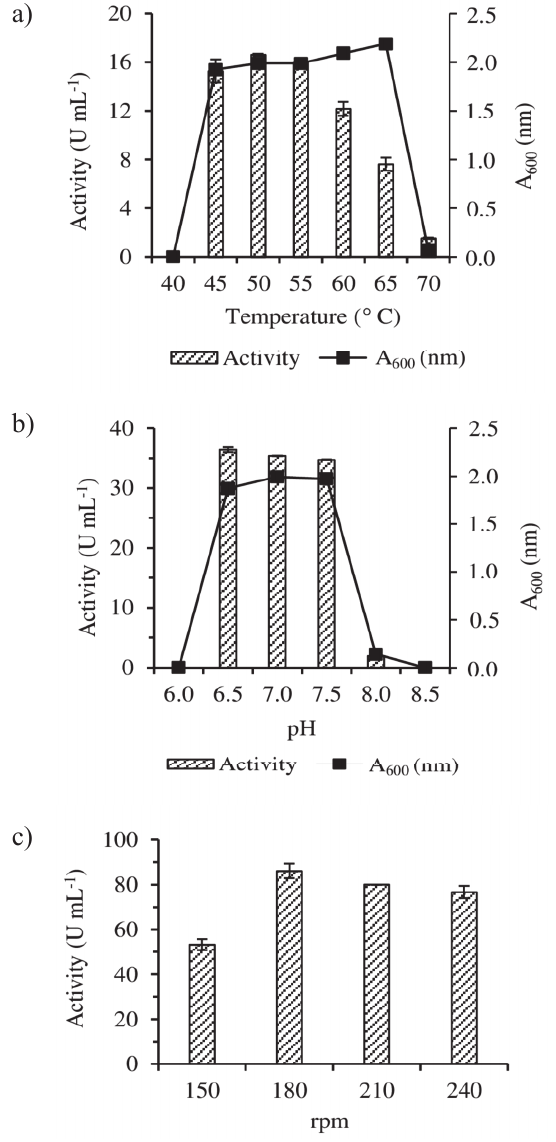
Fig. 2 – Effect of temperature, initial pH and agitation speed on lipase production a) Anoxybacillus sp. HBB16 was grown on LB medium at different temperatures and pH 6.5 for 24 h b) Anoxybacillus sp. HBB16 was grown on LB medium at different pHs at 50 °C for 24 h c) Anoxybacillus sp. HBB16 was grown at 50 ° C and pH 6.5 for 24 h on LB medium with different shaking speeds. The values are the means of three different cul-